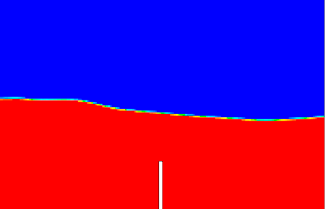
20 of 23 Figure 31. Comparison of the SPH results obtained with 2.00 h x = Δ